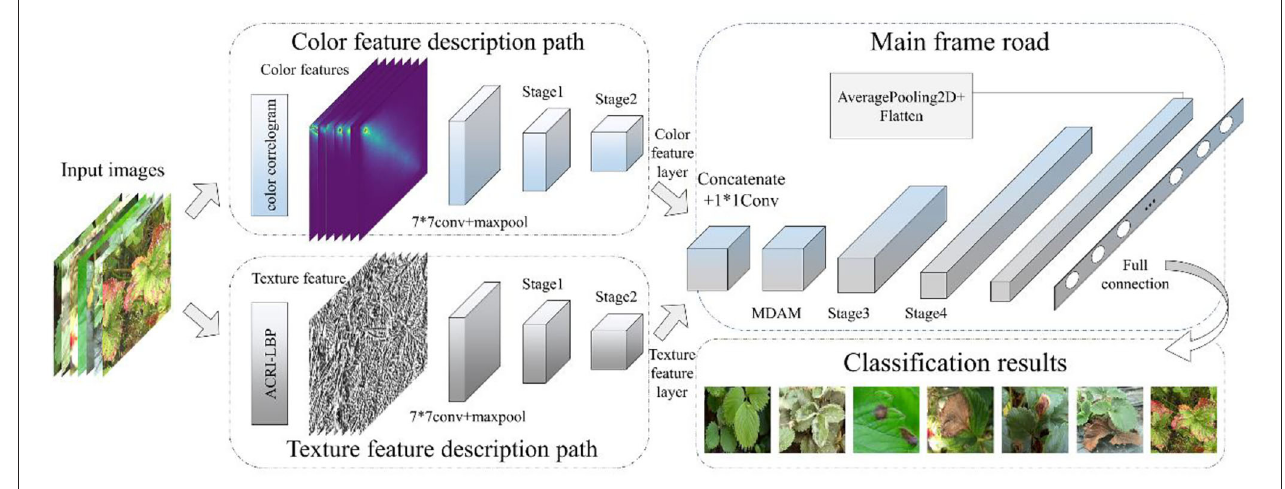
FIGURE 2 | Structural diagram of MDAM-DRNet network.